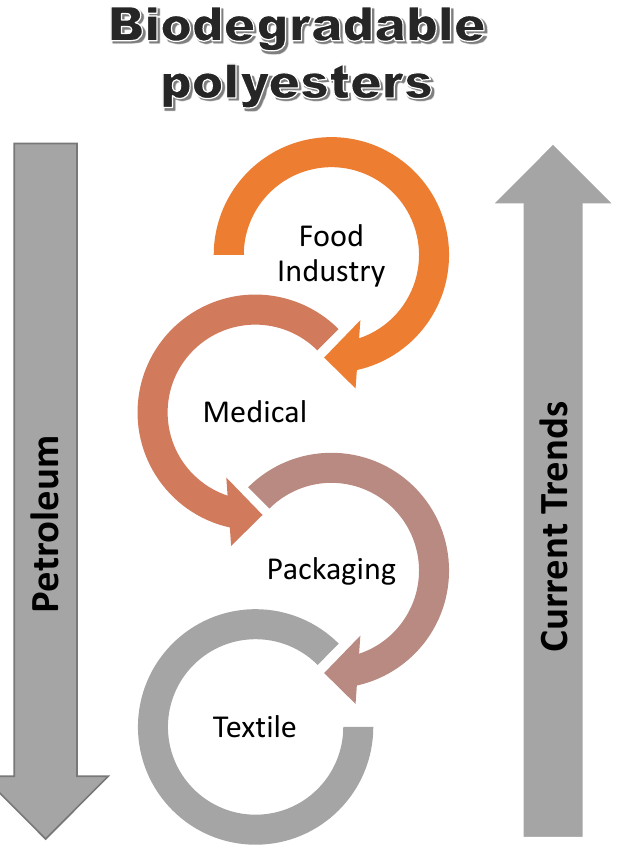
Figure 15. Current trends in the use of biodegradable polyester vs petroleum-based coatings [147]. Table 2. Other applications of polyesters . Table 2. Other applications of polyesters.